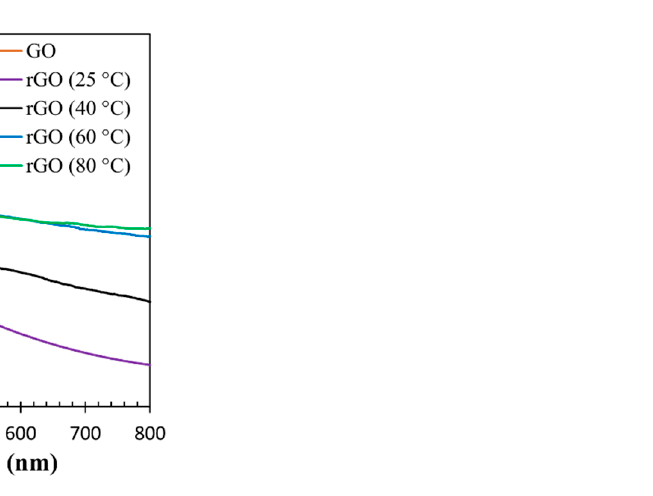
using lemon juice (conditions: pH = 12.3 and 80 °C).